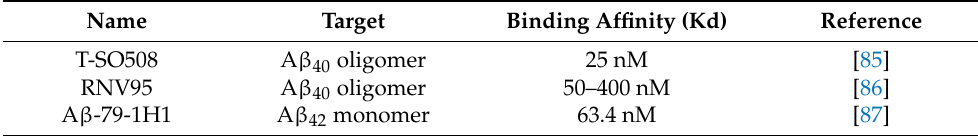
Table 4. DNA aptamers with respective target and binding